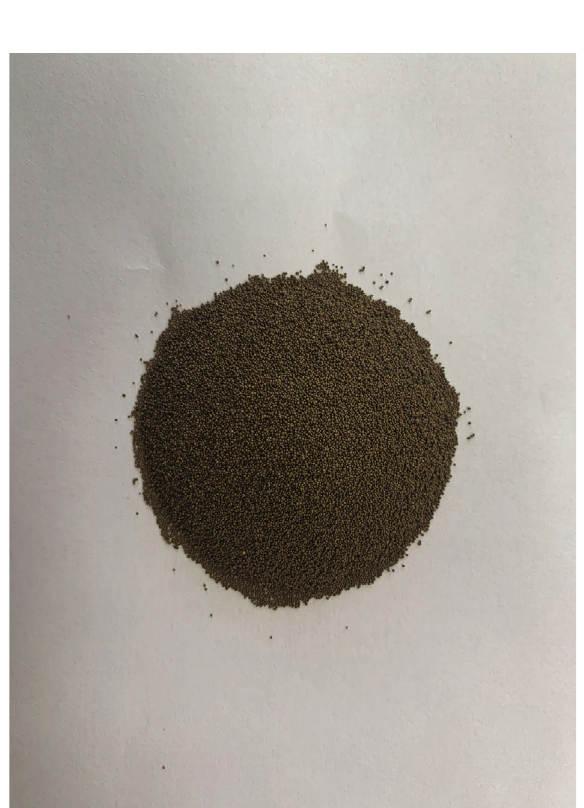
Figure 1: 40/70 mesh ceramsite proppant